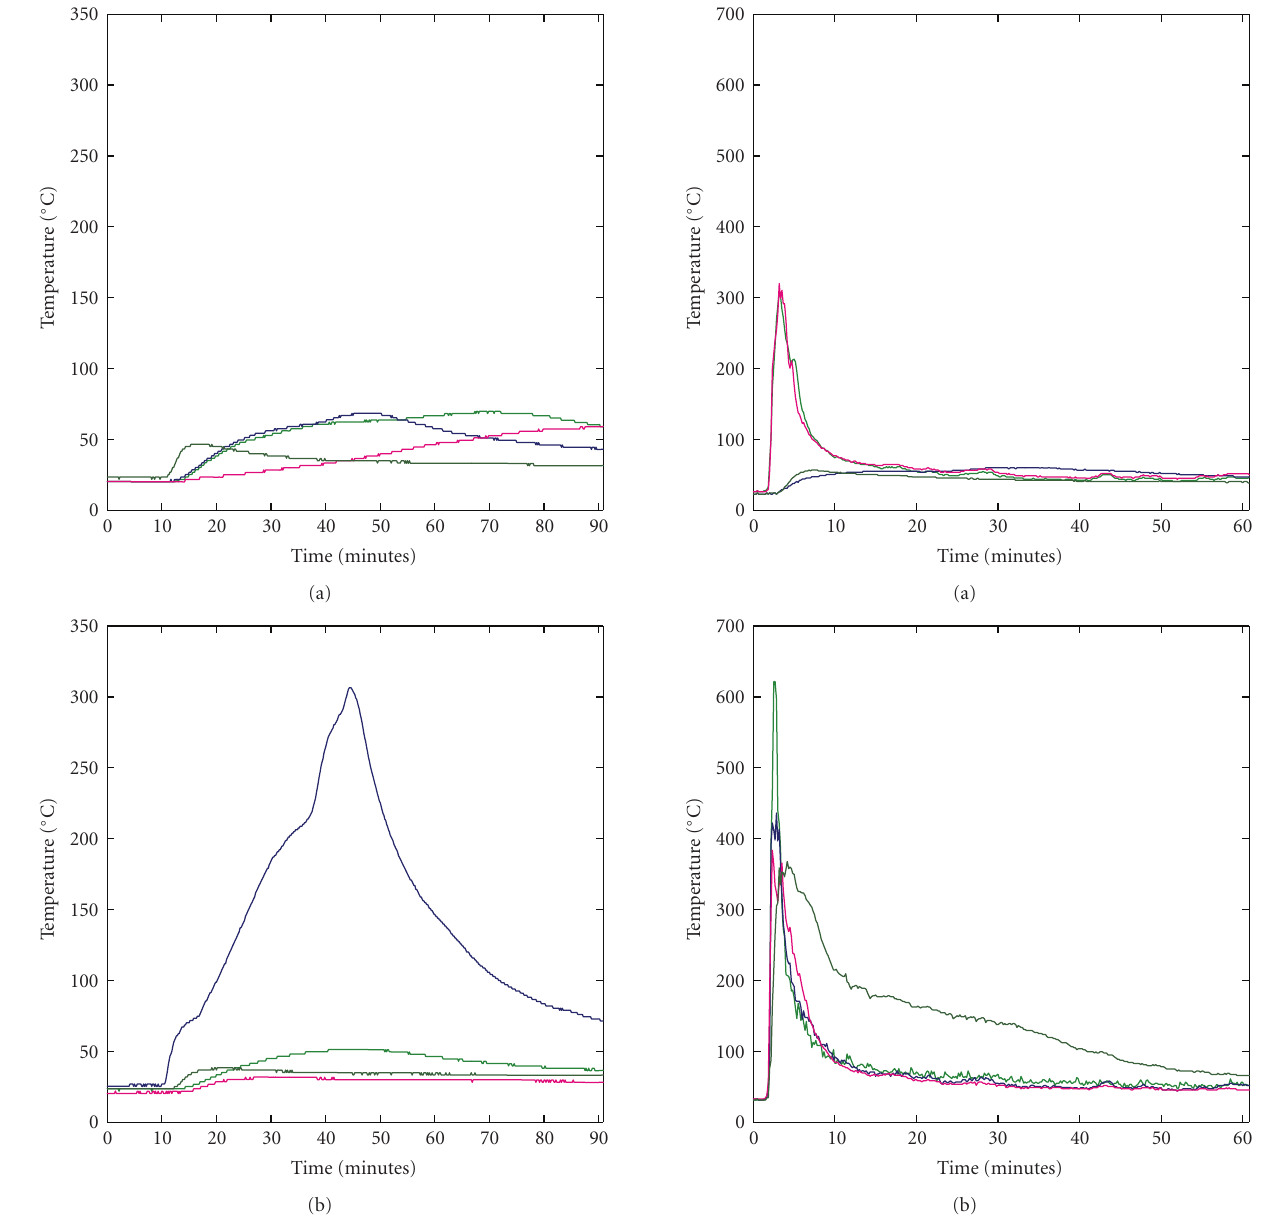
Figure 2: Soil temperatures at 2cm depth during a prescribed sand pine scrub fire at Ocala National Forest, Florida on May 10, 1993. Temperatures were recorded with copper-constantan thermocouples placed in vegetated (a) and open (b) microsites. Each microsite location was replicated four times.